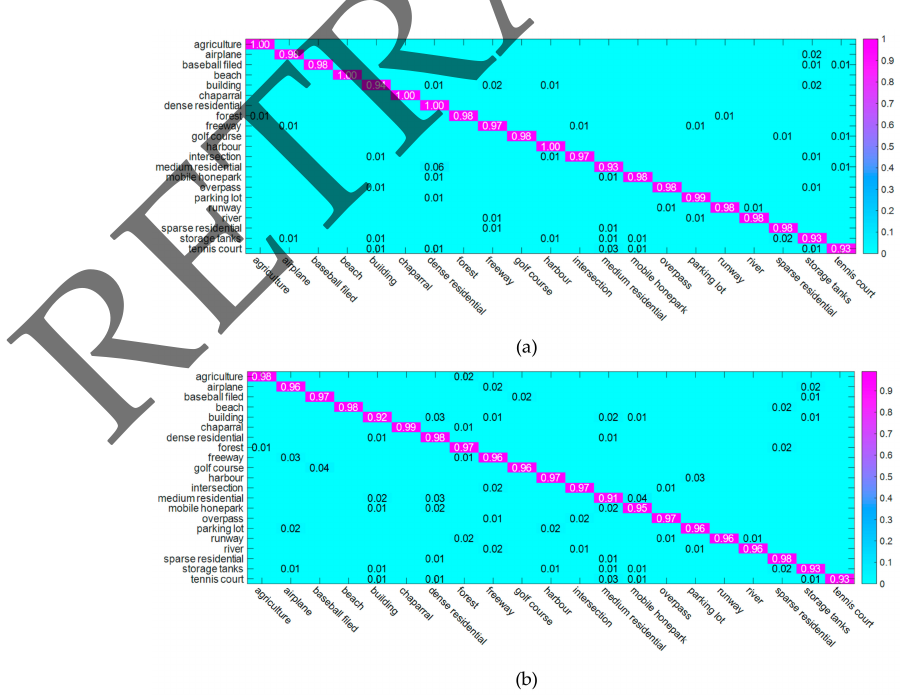
Figure 10. The confusion matrices of the ADFF approach for the UC Merced dataset; ( a ) 80% training ratio, ( b ) 50% training